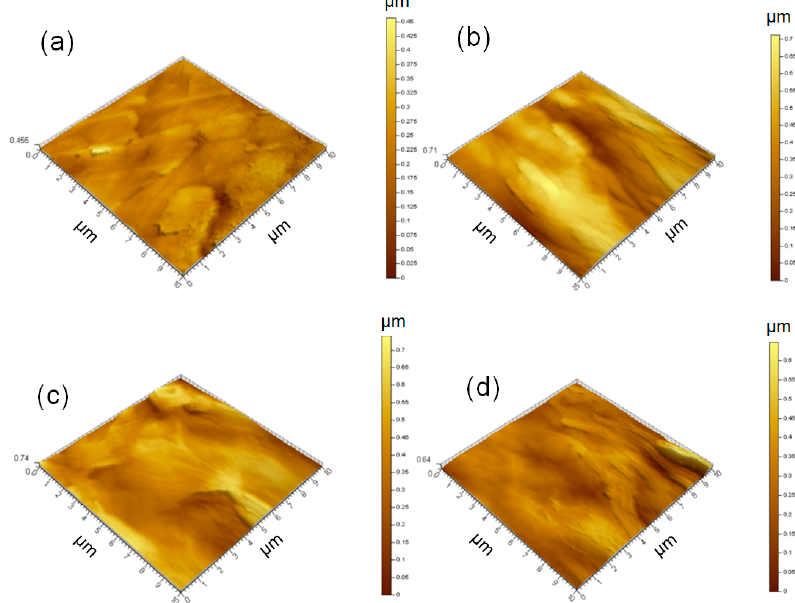
Figure 5. Atomic force microscopy (AFM) analysis on 16 g·m − 2 membranes with ( a ) 30 or ( b ) 50 wt.% graphene; ( c ) 8 g·m − 2 membrane with 50 wt.% graphene, all GO:NFC = 1:1; and ( d ) 16 g·m − 2 − 2 membrane with 50 wt.% graphene, all GO:NFC = 1:1; and ( d ) 16 g · m − 2 membrane membrane with 50 wt.% graphene, GO:NFC = 1:9. graphene; ( c ) 8 g · m with 50 wt.% graphene, GO:NFC = 1:9.